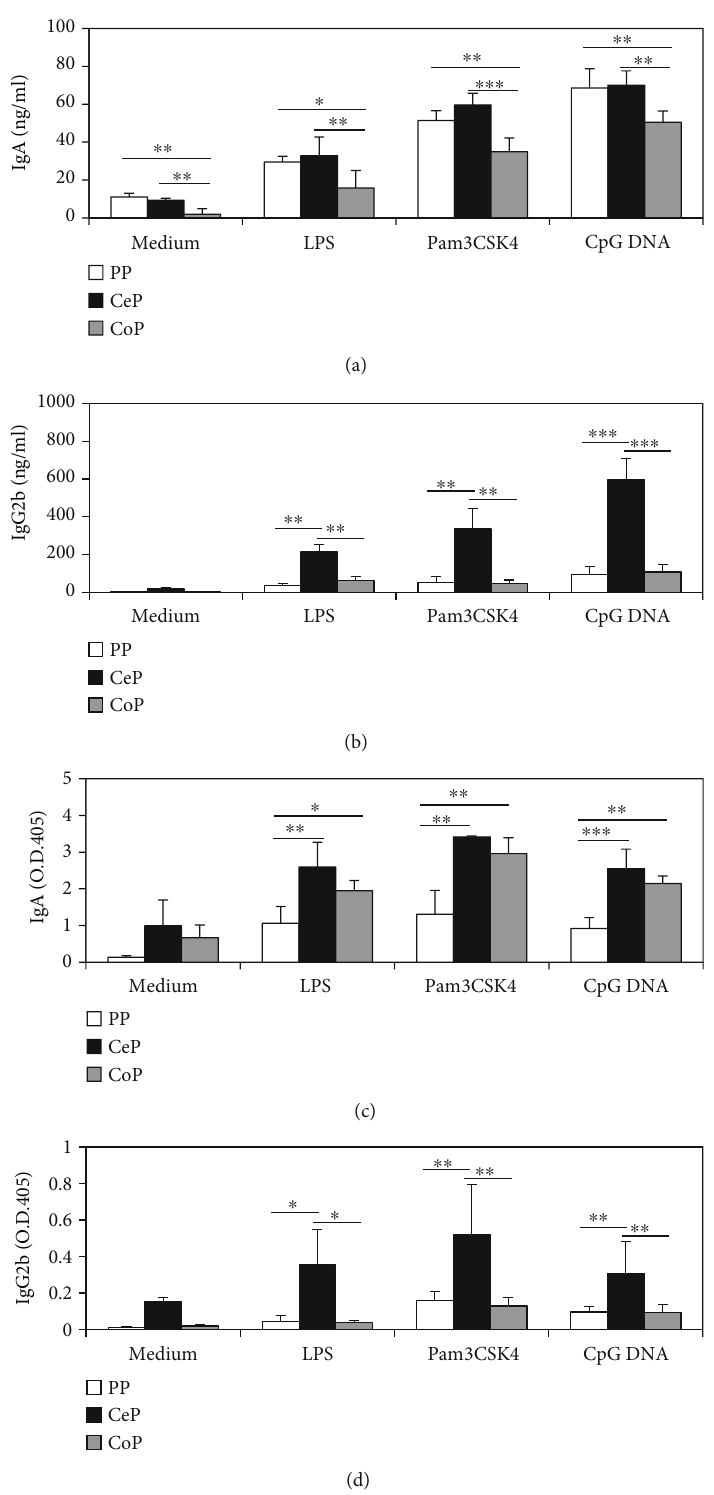
Figure 4: Production of the di ff erent antibody isotypes by GALT cells from small and large intestines. Mononuclear cells from GALT in CV BALB/c mice were stimulated in vitro with 1 μ g/ml LPS, 1 μ g/ml Pam3CSK4, or 1 μ M of CpG DNA for 7 days. (a, b) The concentrations of total IgA and IgG2b in the culture supernatants were measured by ELISA. Data are shown as mean ± SD . (c, d) The levels of fecal bacteria- reactive IgA and IgG2b in the culture supernatants were measured by ELISA. Antibody titers of fecal bacteria-reactive antibodies are shown as net OD405 units ( sample OD405 – mean OD405of blanks ). The mean OD405 value of blanks was 0.21 for IgA and 0.07 for IgG2b. The results are representative of at least three independent experiments. ∗ p < 0 : 05 , ∗∗ p < 0 : 01 , and ∗∗∗ p < 0 : 001